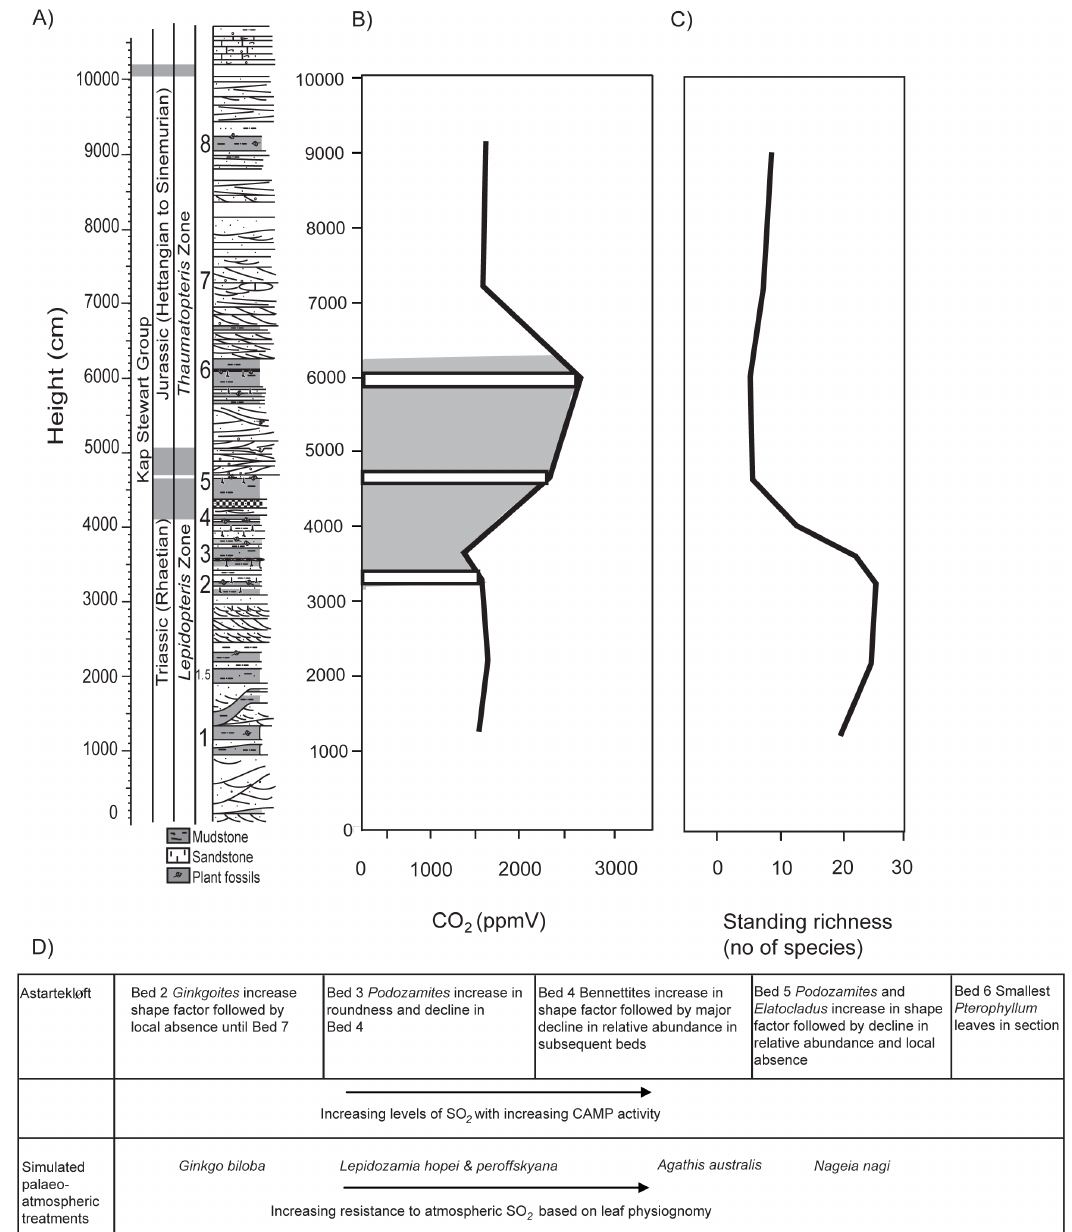
Figure 5. Summary of atmospheric changes compared to standing fossil richness recorded at Astartekløft and SO 2 responsiveness of both fossil and NLE taxa. Astartekløft stratigraphic log (A) (after [5;25]) compared to atmospheric CO 2 changes (B) [4] with timing of likely high SO 2 [3;34] superimposed in grey, standing species richness (C) [25] and summarized responsiveness of both fossil and NLE taxa (D).